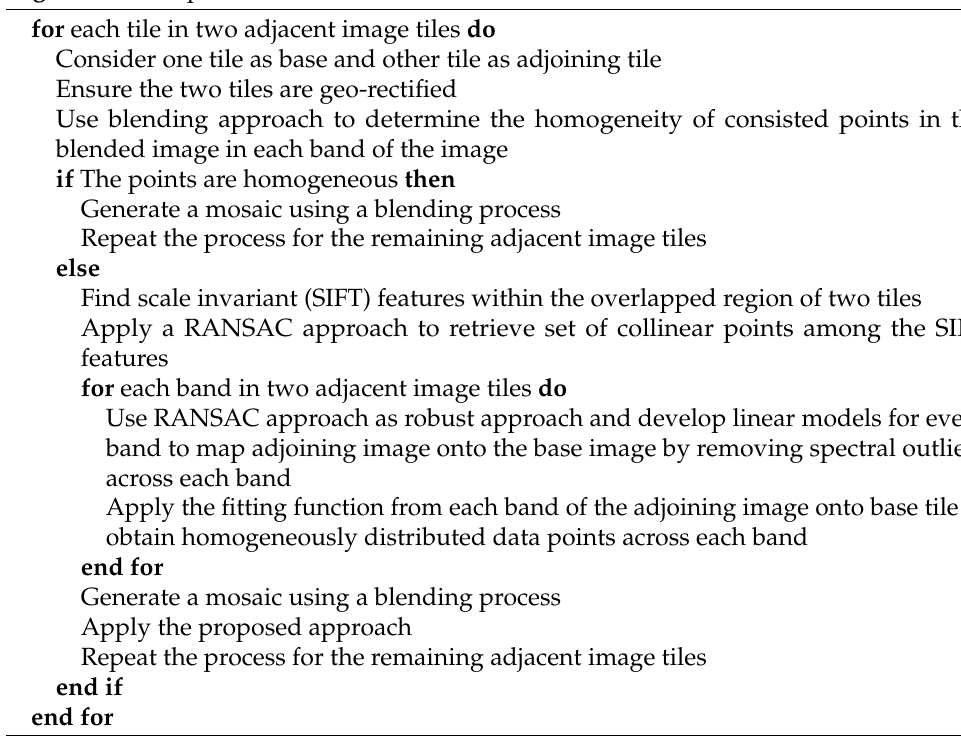
Figure 1. Flowchart of the proposed approach. Algorithm 1 Proposed